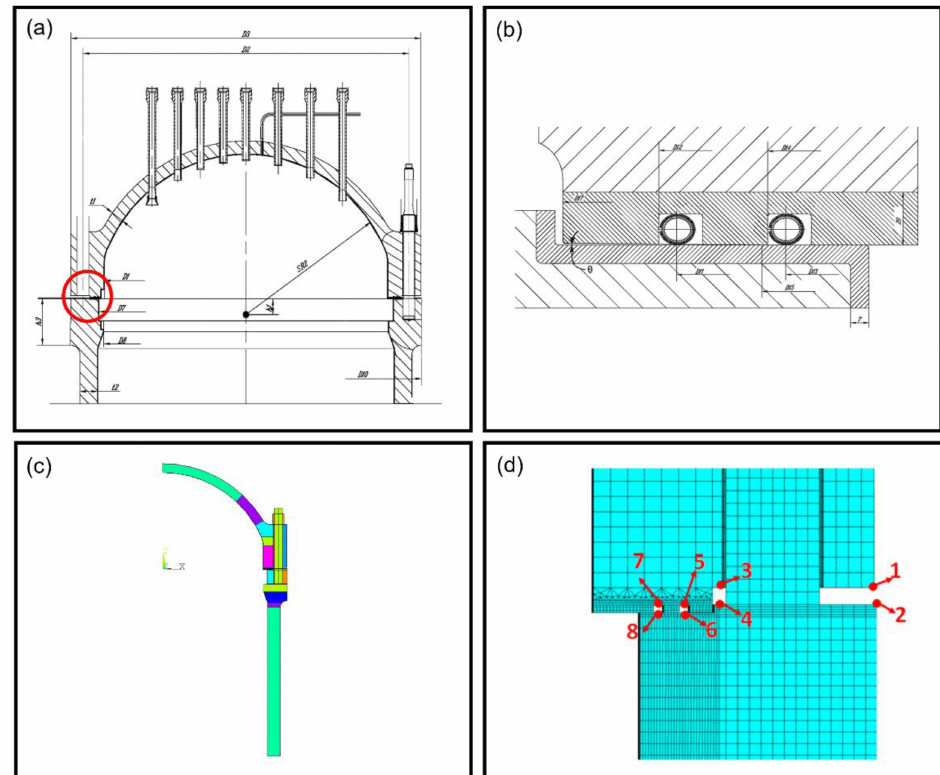
Figure 1. ( a ) RPV dimension parameters; ( b ) partially zoomed figure of dimension parameters in sealing position; ( c ) RPV’s FEA model; ( d ) special location illustration, UY i , UX i are the i -th unit’s Cartesian coordinate positions. ∆ UY i and ∆ UX i are the i -th unit’s displacement in Y and X direction. ( i = 1 . . .